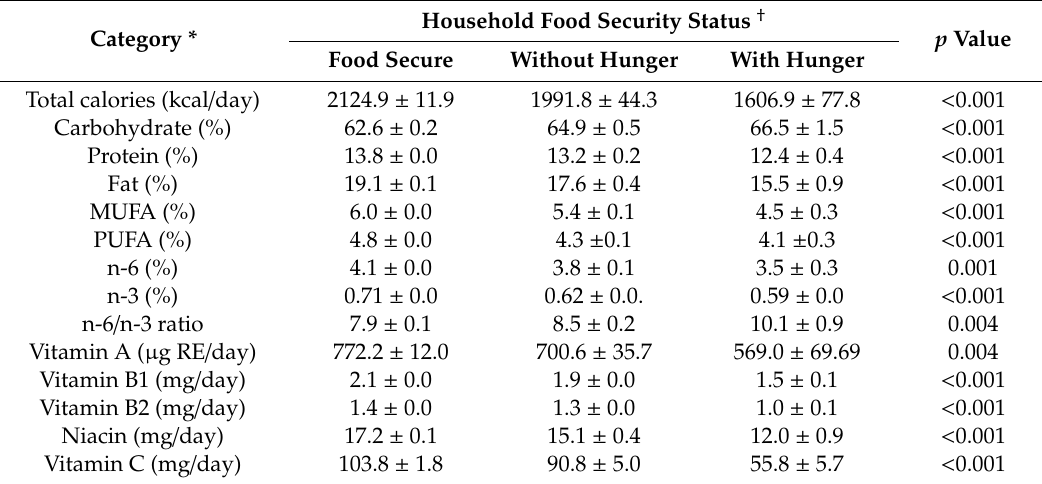
Table 3. Nutrition intake status according to household food security status in Korean adults.